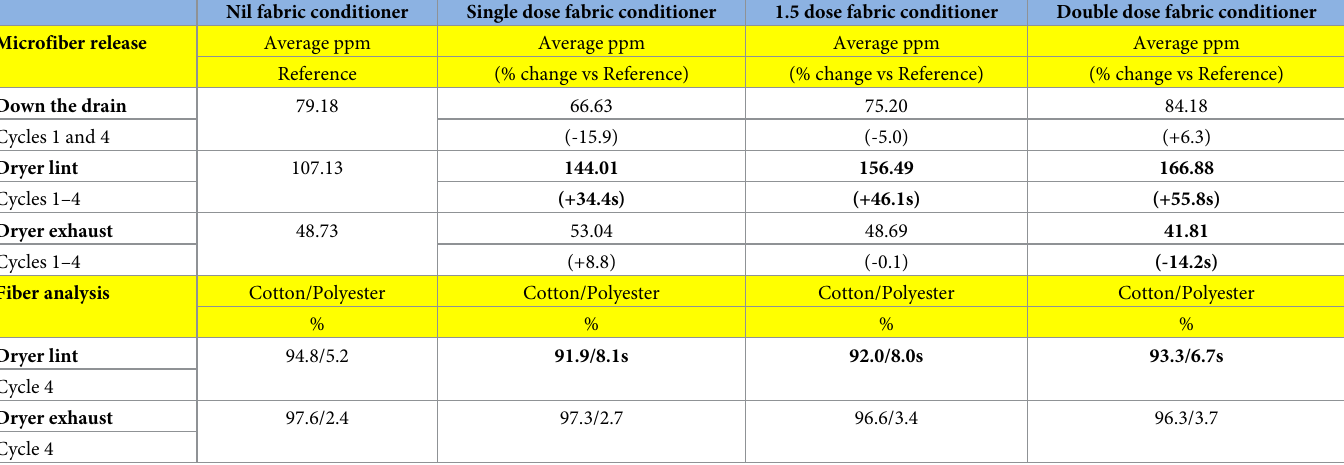
Table 2. Summary of microfiber release and fiber analysis data–Europe liquid fabric conditioner testing.